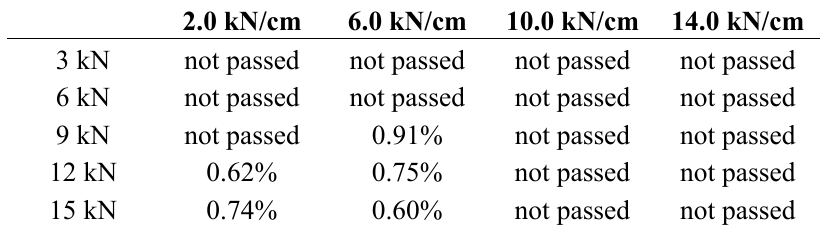
Table 2. Friability test results of isomalt tablets according to Ph. Eur.